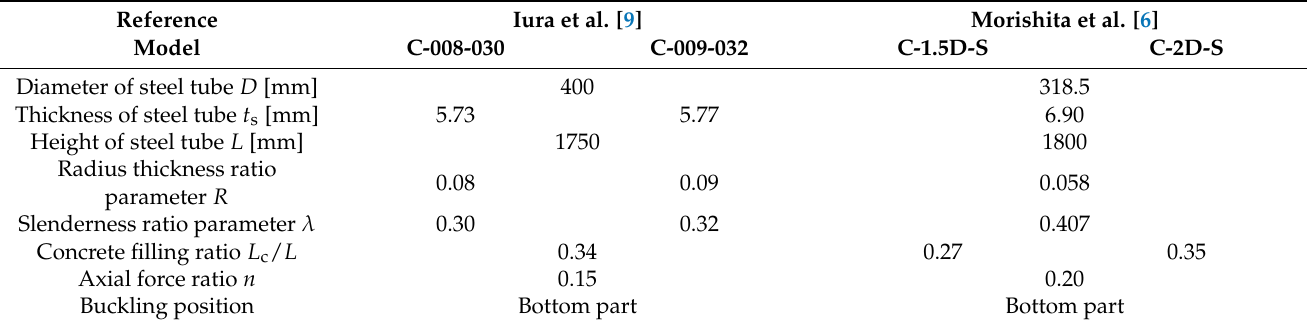
Table 3. Experimental model specifications for